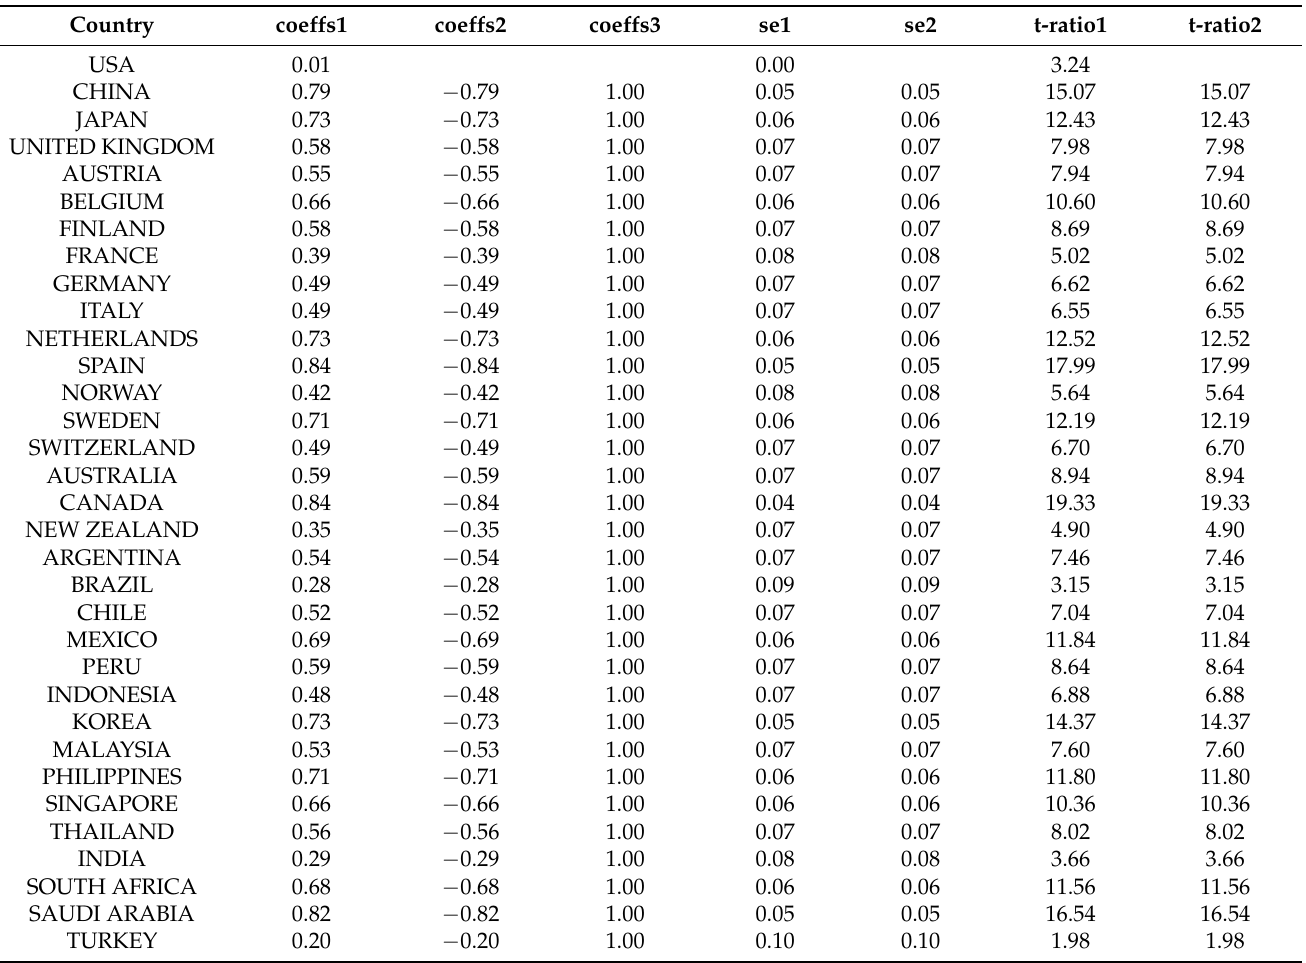
Table A11. Real Exchange equation